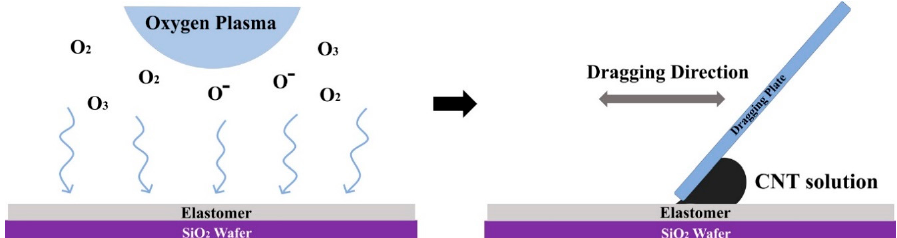
Figure 1. Schematic of direct patterning at the stretchable substrate. O 2 plasma treatment for direct patterning of a carbon nanotube (CNT) by achieving hydrophilicity ( left ) and CNT deposition by meniscus-dragging deposition ( right ) .